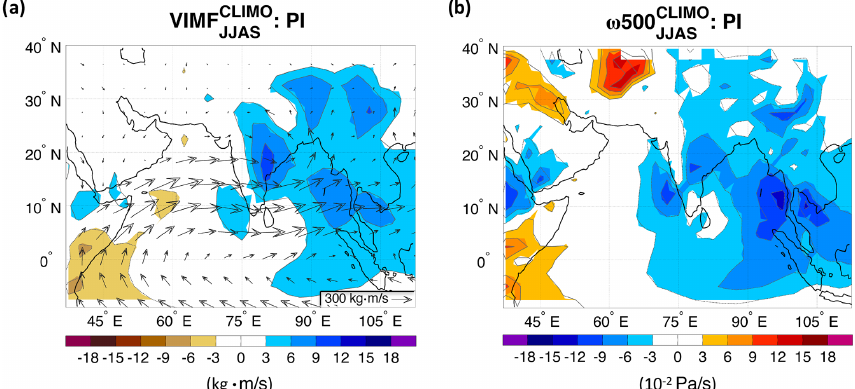
Figure A10. Climatological summer (JJAS) (a) vertical integrated horizontal moisture flux (VIMF, kgm/s) with the arrows representing the zonal and meridional components of the moisture flux; (b) vertical pressure velocity at 500hPa ( ω 500, Pa/s), in the PI